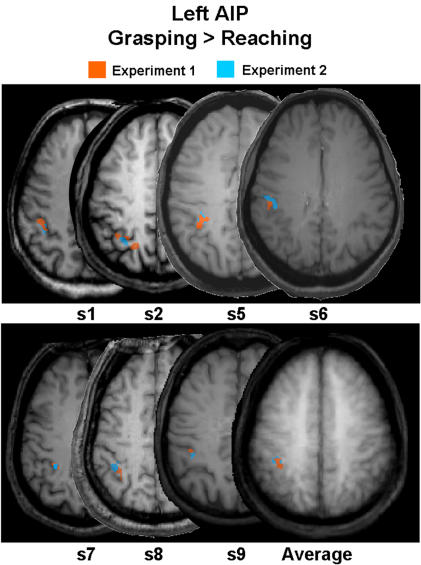
Overlaid activation maps for AIP in Experiment 1 and Experiment 2.Selected clusters of voxel activity for grasping versus reaching in the vicinity of AIP for Experiment 1 (depicted in orange) and for Experiment 2 (depicted in light blue) are overlapped on the same axial slice for each subject and for the averaged group data (rightmost slice). Data for two of the nine subjects (s3 and s4) could not be reported because the passive viewing condition was included in Experiment 1 rather than Experiment 2.